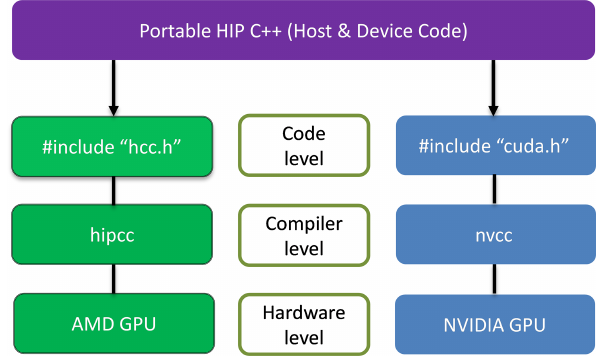
Figure 1. Schematic diagram of the comparison of coding on AMD and NVIDIA GPUs at three